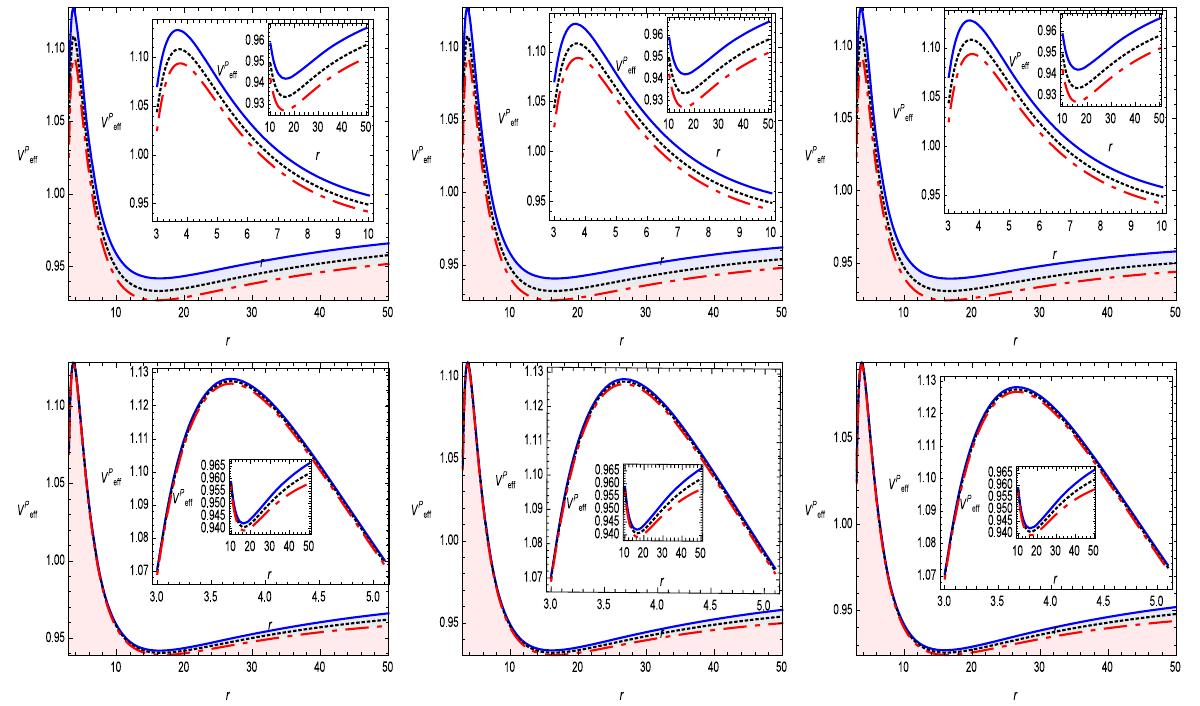
a = 0 . 015 (red) with q = 0 . 00015. The left panel of the second row represents q = 0 . 00001 (blue), q = 0 . 00009 (black), and q = 0 . 00017 (red) with a = 0 . 001. The middle panel of the second row represents q = 0 . 00001 (blue), q = 0 . 00009 (black), and q = 0 . 00017 (red) with a = 0 . 009. The right panel of the second row represents q = 0 . 00001 (blue), q = 0 . 00009 (black), and q = 0 . 00017 (red) with a = 0 .